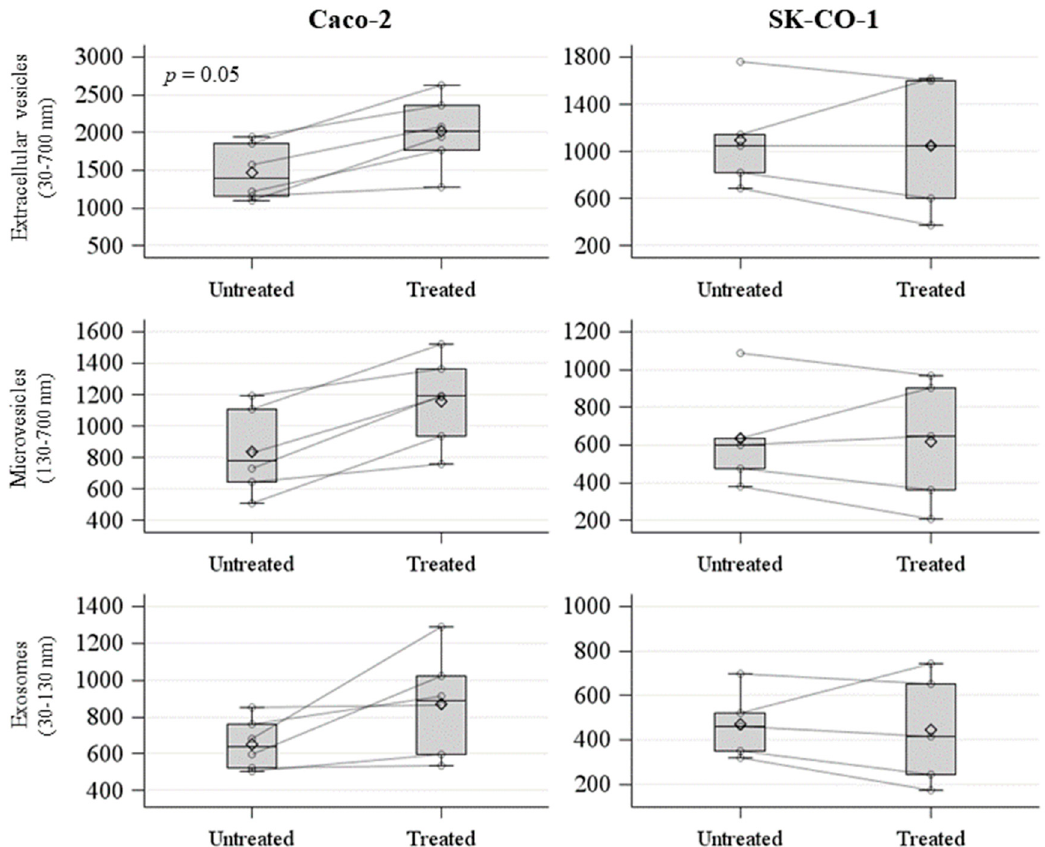
Figure 3. Spaghetti plot and box plot of number of extracellular vesicles (EVs) (count / mL × 10 6 ) derived from untreated and decitabine-treated Caco-2 and SK-CO-1 cells.